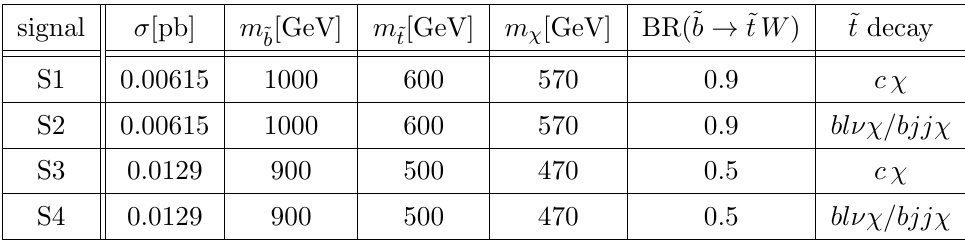
channel (S1 & S2) and the T